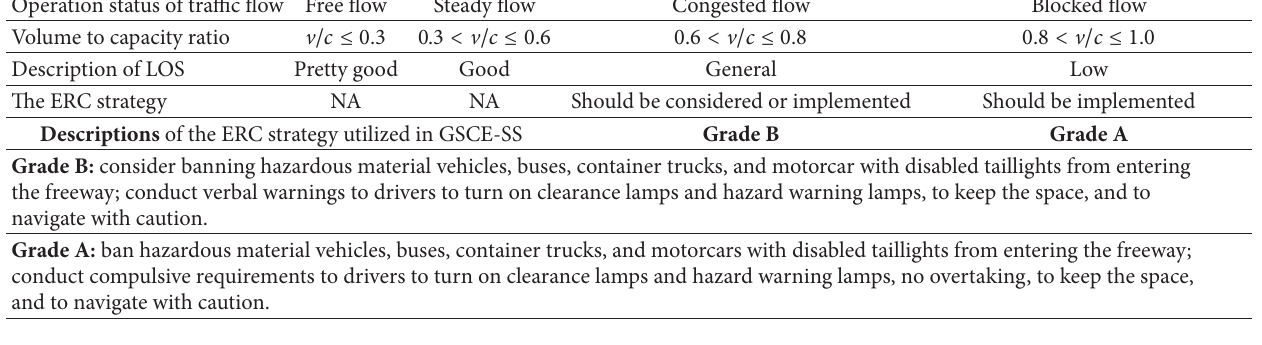
Table 5: The schemes grades and disposal programs of the mainline control